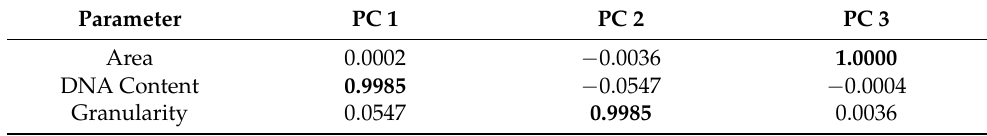
Table 1. PCA coefficient matrix of one of the samples.